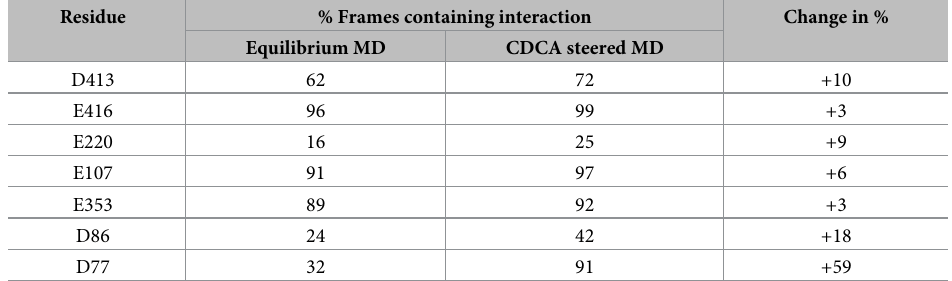
Table 1. Proportion of trajectory frames in which selected acidic residues are observed to coordinate a calcium ion. Residue